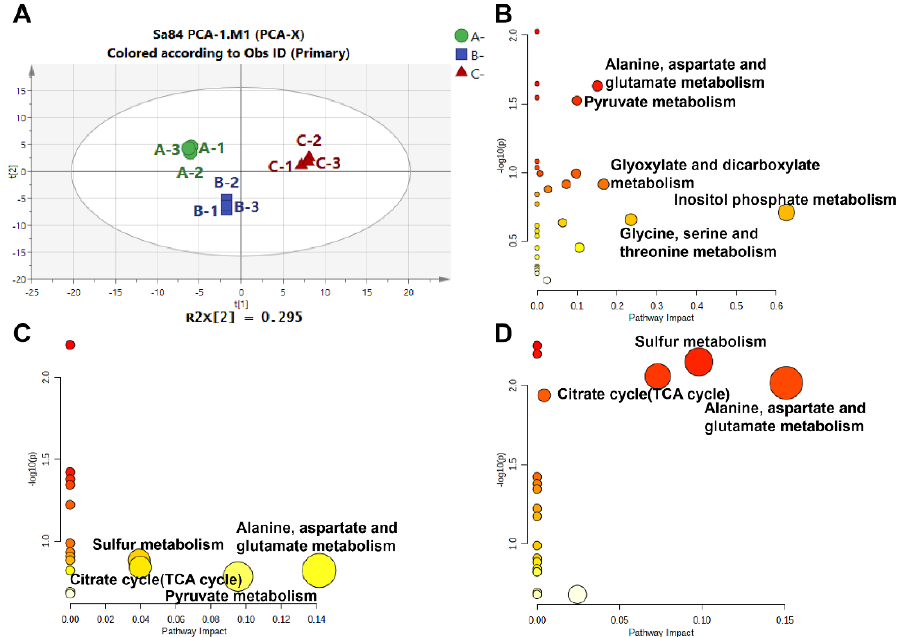
Figure 7. Overview of the metabolome analysis results. ( A ) PCA score plot of the overall metabolites expression; ( B ) KEGG pathways in 0%NaCl vs. 10%NaCl comparison; ( C ) KEGG pathways in 10%NaCl vs. 20%NaCl comparison; ( D ) KEGG pathways in 0%NaCl vs. 20%NaCl comparison.